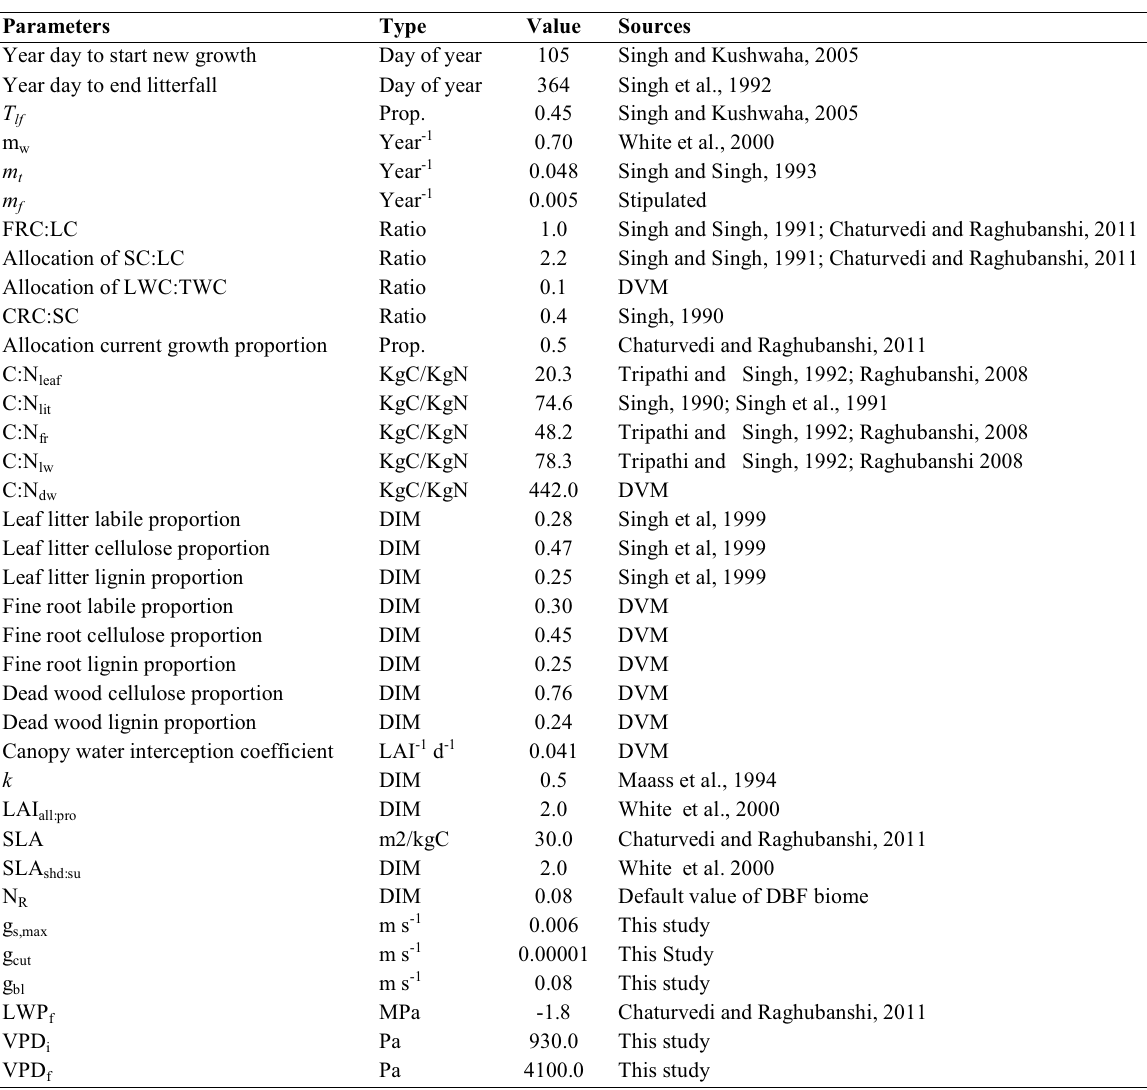
Table 3: Ecophysiological input parameters for model (*DVM = Default value of model for deciduous broadleaf forest (DBF) biome as White et al.